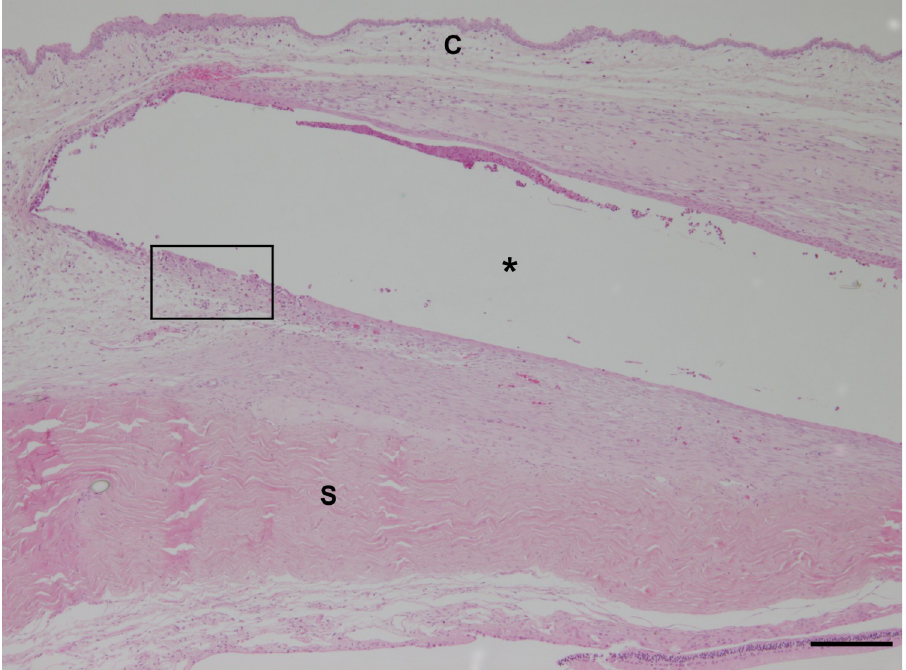
Fig 9. Histological overview of the implant area. A rectangular empty cavity (asterisk) marks the implant area surrounded by sclera (S) and conjunctiva (C). The implant was lost during tissue processing; haematoxylin-eosin staining; bar 200 μ m. In the periphery of the cavity, four animals (4/8) showed mild granulomatous inflammation and one animal (1/8) moderate granulomatous inflammation composed mainly of macrophages and occasional multinucleated giant cells. Furthermore, variable numbers of heterophilic granulocytes, lymphocytes and plasma cells were found (Fig 10).